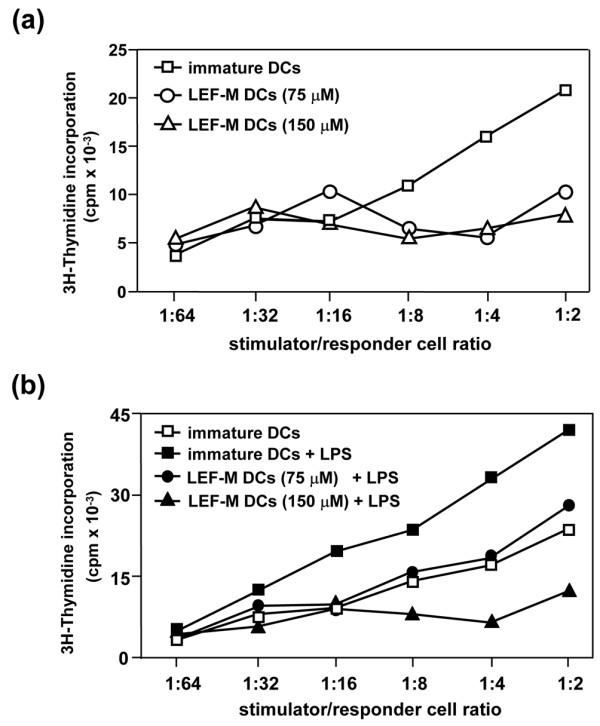
DCs differentiated in the presence of LEF-M exhibit reduced T-cell stimulatory capacity. (a) Monocytes were cultured for 5 days with granulocyte–macrophage colony-stimulating factor (GM-CSF; 50 ng/ml) plus IL-4 (10 ng/ml) in the presence or absence of the indicated concentrations of LEF-M. Dendritic cells (DCs) differentiated in the presence of the active metabolite of leflunomide (LEF-M) are labelled 'LEF-M DCs' in the figure. The cells were extensively washed, irradiated (3000 rad) and subsequently co-cultured with 1 × 105 purified allogeneic T cells at the indicated ratios. (b) To determine maturation sensitivity, DCs differentiated in the presence or absence of LEF-M were exposed to 100 ng/ml lipopolysaccharide for an additional 48 hours. Then, the cells were employed as allogeneic stimulators, as described above. DNA synthesis was assessed at day 5. The standard deviation of the counts/min (cpm) for the respective triplicates was generally below 20%. Shown are the means of at least eight independent experiments.